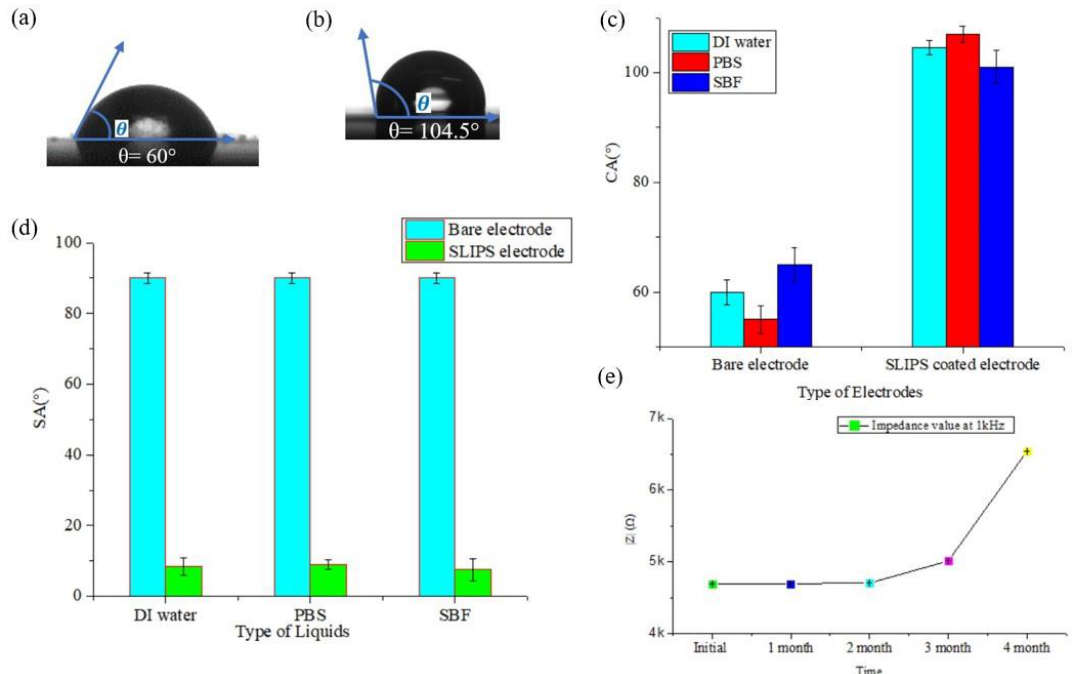
Figure 8. DI water droplet on the SLIPS surface ( a ) before the SLIPS coating, which is hydrophilic, and ( b ) after the SLIPS coating, which is hydrophobic. ( c , d ) CA and SA for various fluids where the samples are taken from three different locations. ( e ) The long term stability test for four months.